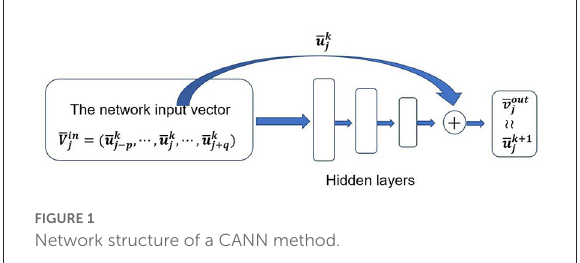
FIGURE1 Network structure of a CANN